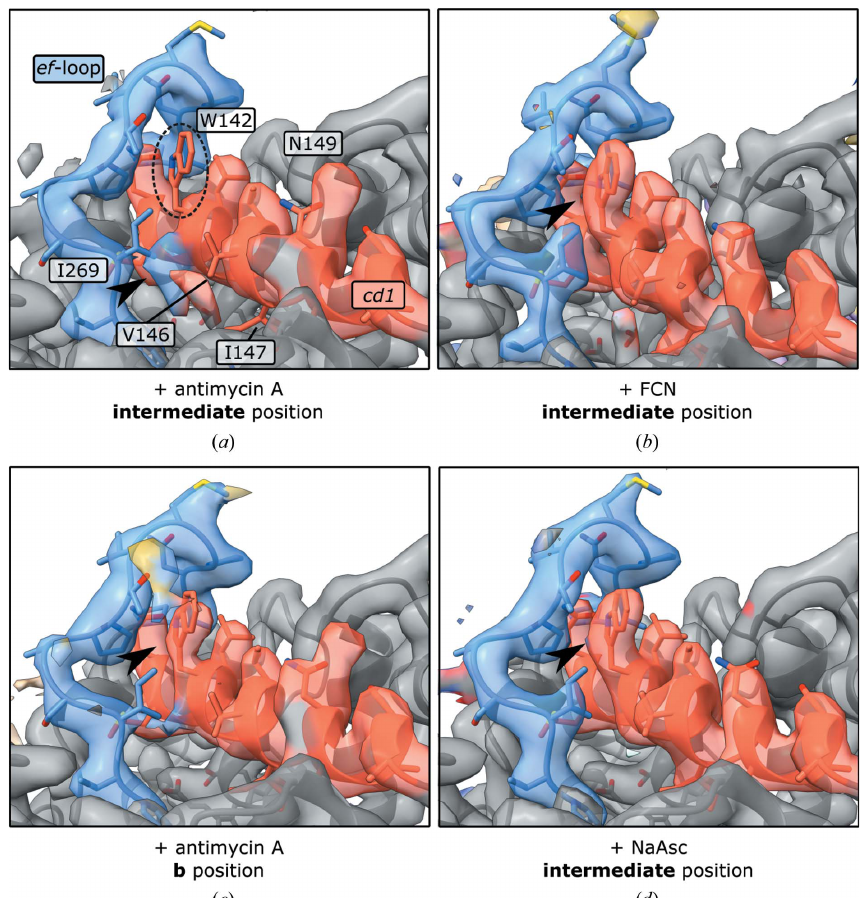
Figure 5 Cyt b in samples of CIII 2 prepared with antimycin A ( a , c ), oxidized with ferricyanide ( b ) or reduced with ascorbate ( d ). ( a ) Density for Trp142 (dashed ellipse) of the cd 1 -helix and Ile269 of the ef -loop was missing in maps of CIII 2 with only antimycin A added when the Rieske domain (cropped out, residual yellow density) was in the intermediate position. Additional density was visible at a position near the Q o site on the left of the cd 1 -helix, partially overlapping with the position of Ile269 of the ef -loop (arrow). Densities for Val146, Ileu147, Cys148 and Asn149 were ambiguous as in the apo sample (Supplementary Fig. S7). ( c ) With the Rieske domain in the b position, density for Trp142 was resolved in the expected position beneath the ef -loop, as in samples with added ferricyanide ( b ), ascorbate ( d ), DQH 2 or DQ. All side chains of the ef -loop and cd 1 -helix were also resolved with the Rieske domain in the intermediate position. The overall resolutions of the maps were 3.0 A˚ ( a ), 3.0 A˚ ( c ), 2.3 A˚ ( b ) and 3.2 A˚ ( d ). In the apo sample, density for Trp142 was also weaker when the Rieske domain was in the intermediate position (Supplementary Fig.